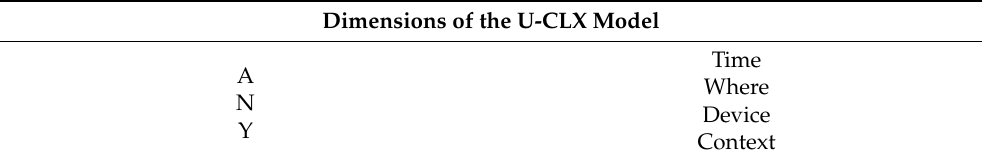
Table 1. U-CLX Model